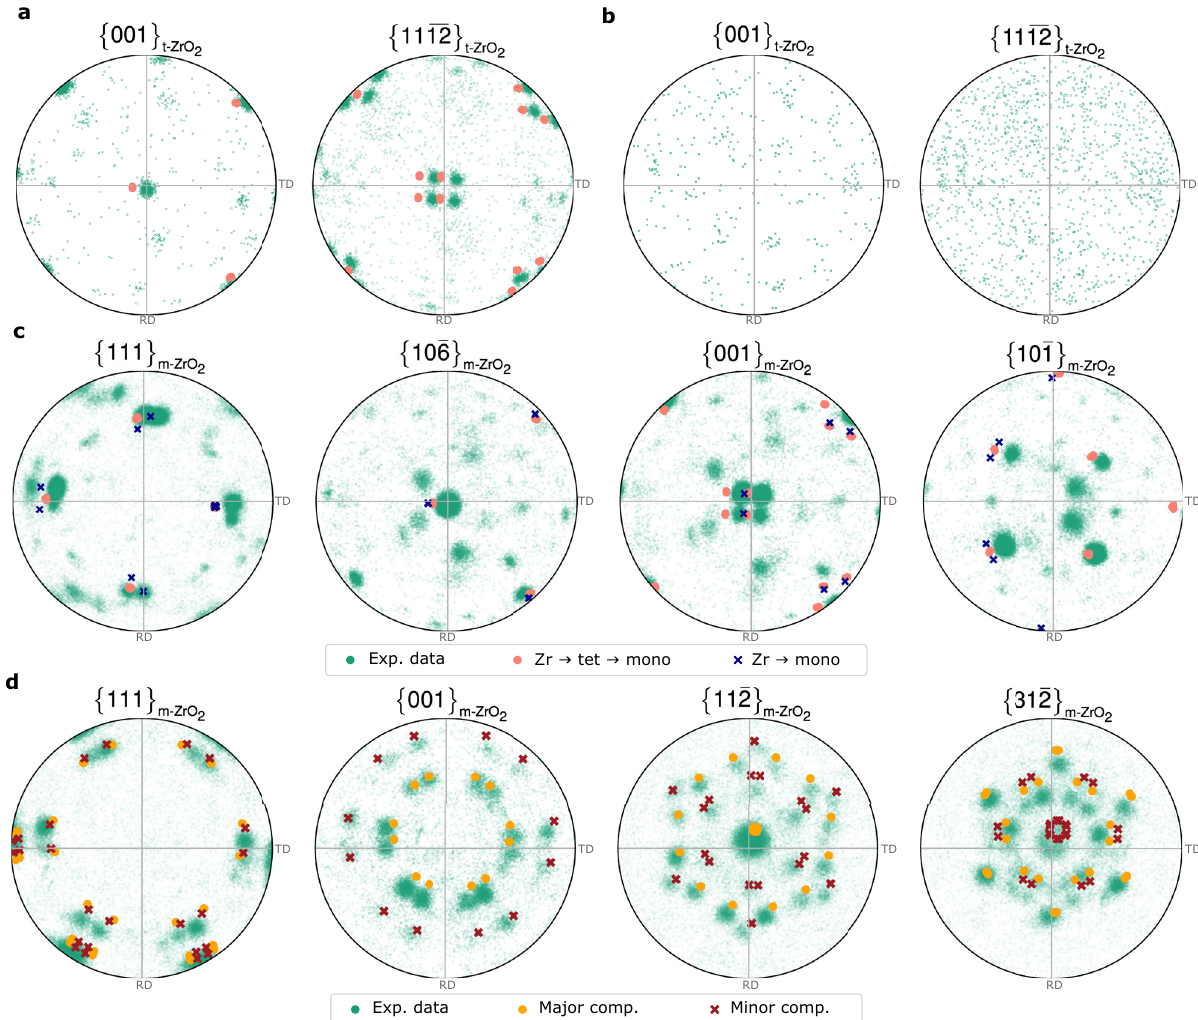
Fig. 3 | Electron backscatter diffraction and theoretical crystallographic and f 31 (cid:1) 2 g of monoclinic ZrO 2 in oxide region 2. Denoted with orange disks and orientation data. a , b Raw pole fi gures for equivalent poles f 001 g and f 1112 g of red crosses are the major and minor theoretical orientation relationships f 11 (cid:1) 2 g (cid:1) 2 g <111> ∣∣ f 0002 g <1 (cid:1) 100> ∣∣ f 0002 g <1 (cid:1) 100> tetragonal ZrO 2 in oxide region 1 ( a ) and 2 ( b ). c Raw pole fi gures of monoclinic <111> m (cid:2) ZrO Zr and f 31 m (cid:2) ZrO 2 Zr . All con- 2 ZrO 2 for equivalent poles f 111 g , f 10 (cid:1) 6 g , f 001 g and f 10 (cid:1) 1 g in oxide region 1. Denoted toured pole fi gured are normalised to multiples of a random distribution (MRD) with pink disks and blue crosses are possible theoretical orientation relationships and oriented to be consistent with the EBSD map in Fig. 1 with TD|| x axis, RD|| y (cid:1) 1> ∣∣ f 101 g <11 (cid:1) 2> ∣∣ f 0002 g <11 (cid:1) 20> ∣∣ f 0002 g f 111 g <10 (cid:1) 1> m (cid:2) ZrO axis and ND|| z t (cid:2) ZrO 2 Zr and f 111 g <10 m (cid:2) ZrO 2 2 <11 (cid:1) 20> Zr , respectively. d Raw pole fi gures for equivalent poles f 111 g , f 001 g , f 11 (cid:1) 2 g